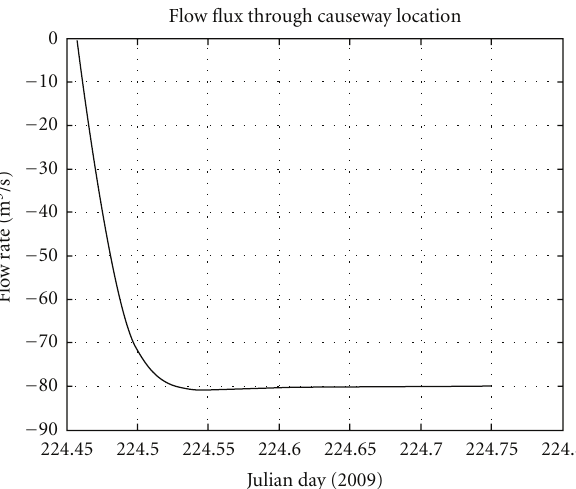
Figure 13: The exchange flow rate (m 3 /s) passing through the causeway region changing with time under strong constant east wind of 10